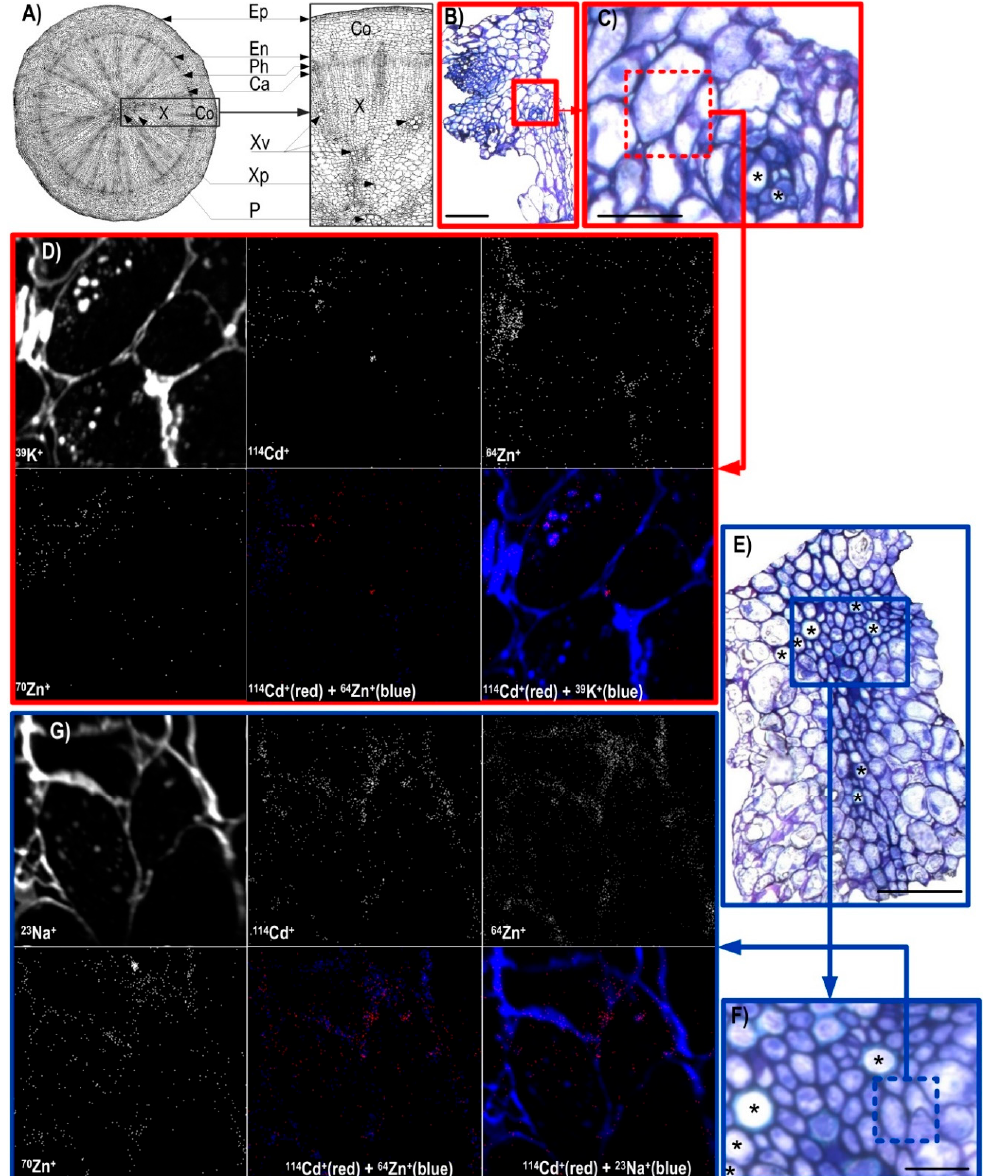
Figure 2. ( A ) Schematic presentation of fully-developed radish hypocotyl tissue in the cross section (left) with a part enlarged (right). Ep, epidermis; Co, cortex; En, endodermis; Ph, phloem; Ca, cambium; X, xylem; Xv, xylem vessel; Xp, xylem parenchyma; P, Pith. ( B , C , E , F ) Optical micrographs of the Araldite 502 resin-embedded transversal sections of 18-day-old radish ( Raphanus sativus L. cv. Cherry Belle) edible hypocotyl tissue exposed to the equimolar (2.2 µ M ) Cd/ 70 Zn treatment for 24 h